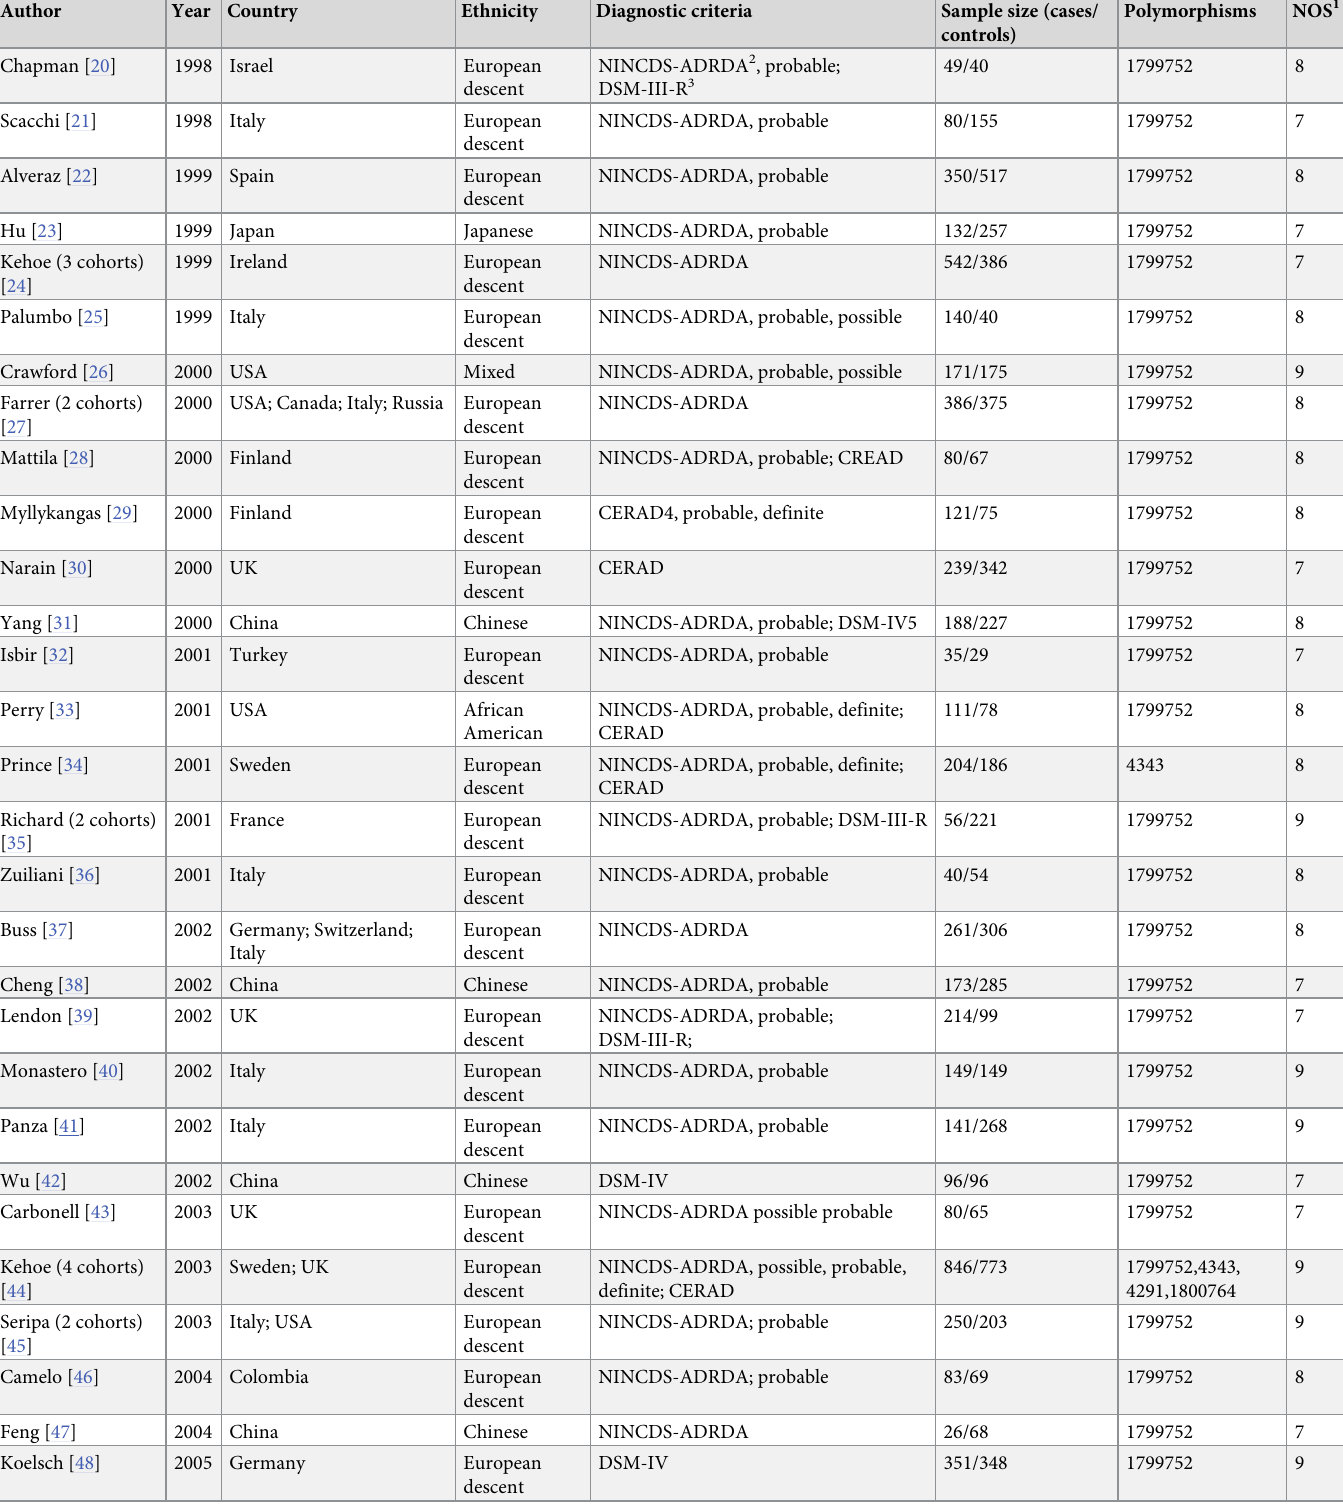
Table 1. General characteristics of included studies in the present